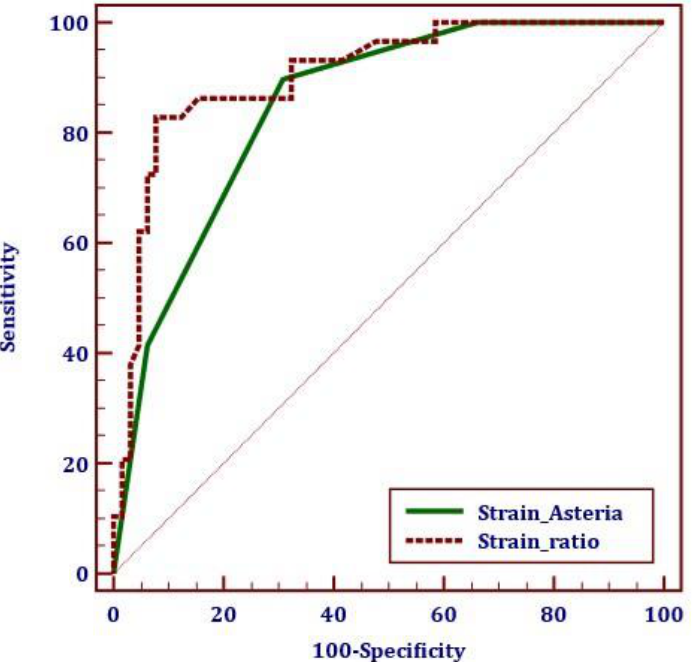
Figure 5. The performance of SE parameters in the diagnosis of thyroid cancer (receiver operating characteristic curve): the strain ratio and Asteria score/colormap analysis.